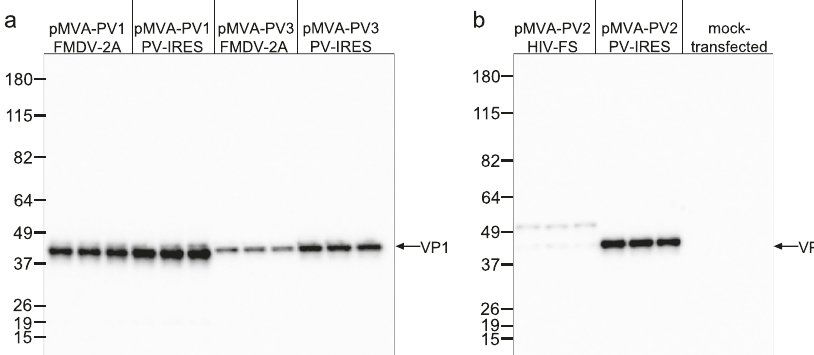
Fig. 3 Expansion of expression screen using transient assay. a , b Western blot analysis of lysates from GMK cells infected with MVA-T7 and transfected in triplicates with pMVA-PV1_FMDV-2A, pMVA-PV1_PV-IRES, pMVA-PV3_FMDV-2A, pMVA-PV3_PV-IRES (panel a ) and pMVA- PV2_HIV-FS, pMVA-PV2_PV-IRES or mock-transfected (panel b ). Detection was via anti-poliovirus blend of monoclonal antibodies MAB8566 (Fig. 5a, c). Interestingly PV2 wt VLPs displayed D-antigenicity, quantitated by reference to IPV as a total of 600 D-antigenic (D-